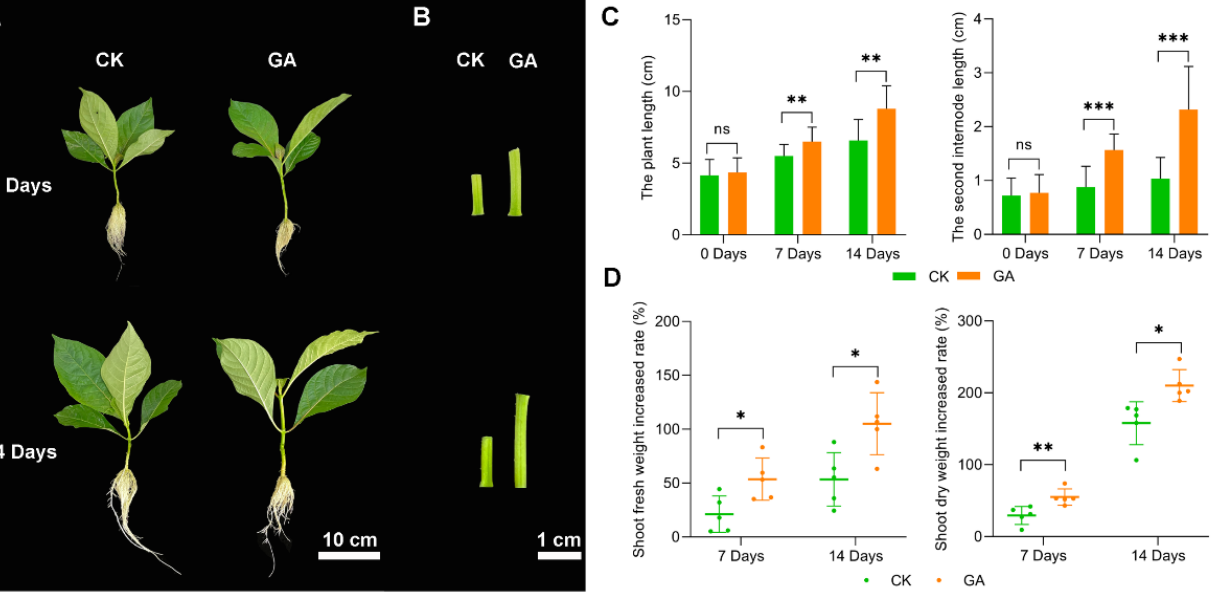
Figure 1. Growth of N. cadamba under exogenously applied 50 µM/L GA group (GA) and CK group (CK). ( A ) N. cadamba morphology of GA group and CK group at 7 d and 14 d. ( B ) The second internode of N. cadamba morphology of GA group and CK group at 7 d and 14 d. ( C , D ) Plant height, length of second internode section, shoot fresh weight increased rate, and shoot dry weight increased rate of CK group and GA group at different times. Results are mean ± SD of three biological replicates. Differences between mean values of CK and GA were compared using the student’s t-test (ns, *, **, and *** denote no significant difference, significant differences at p < 0.05, 0.01 and 0.001).